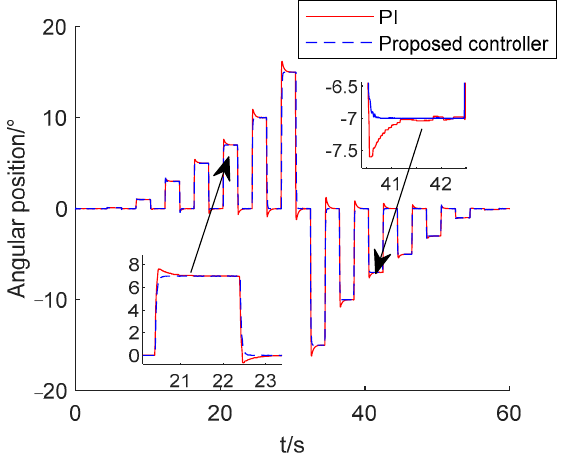
Table 5. Comparison of tracking performance of step signals.